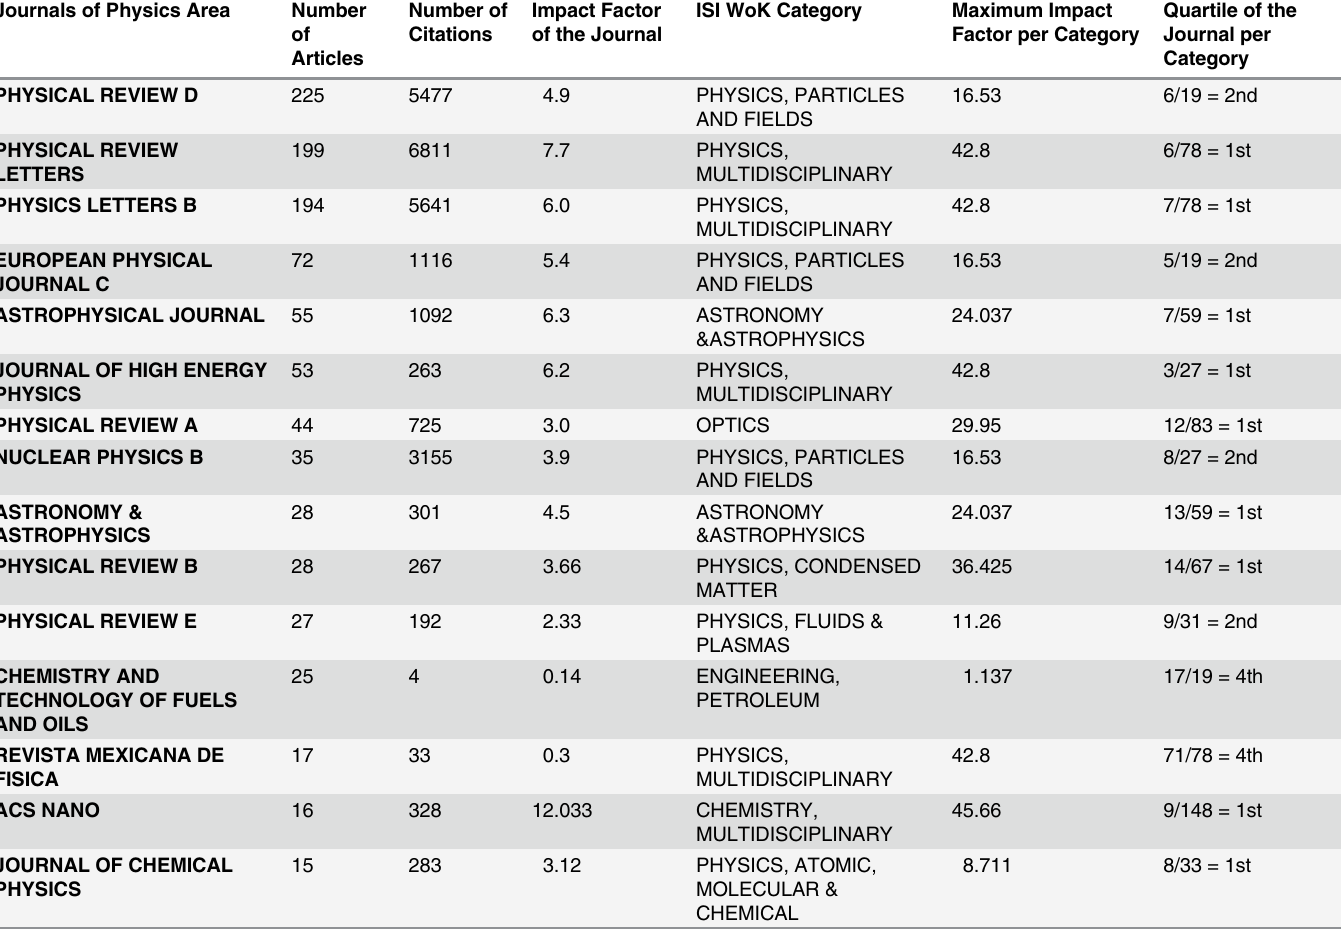
Table 17. Mainstream journals with the highest number of papers by the Mexican Diaspora in physics with their citations (closed to December 2013) and the respective JCR impact factors